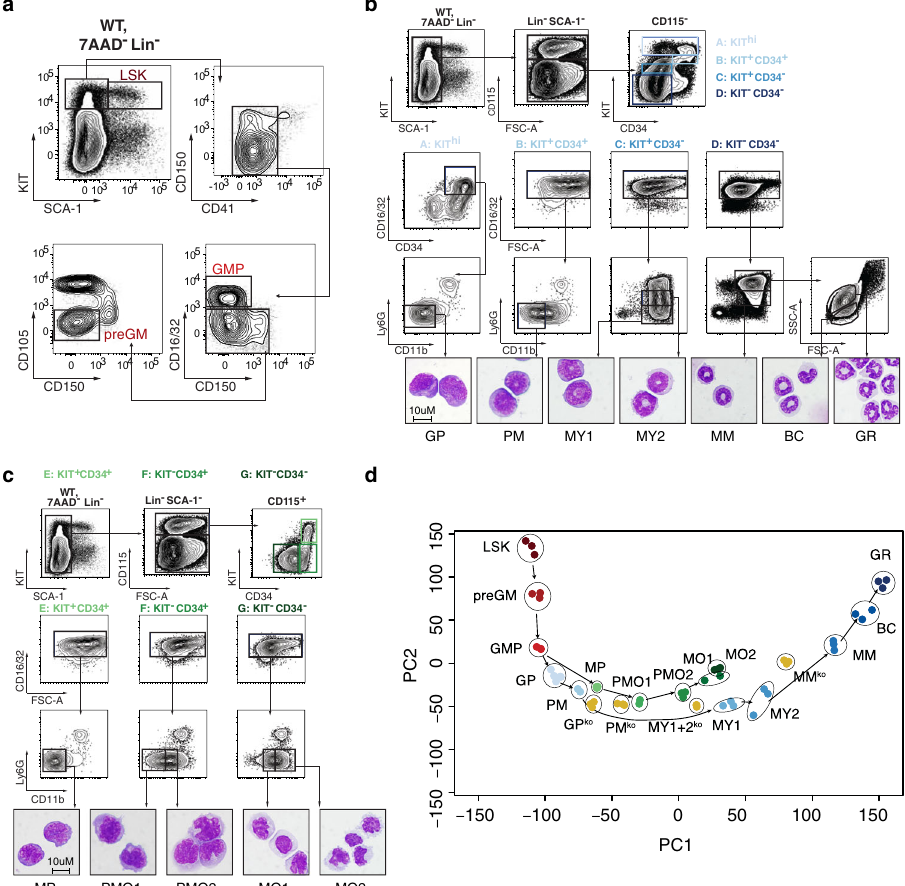
Fig. 1 High-resolution immunophenotypic and transcriptome mapping of steady-state granulocytic and monocytic differentiation hierarchies. a – c Flow cytometry-based gating strategy for sorting of murine bone marrow (BM) populations representing early stages of myeloid (i.e., granulocytic-monocytic) differentiation ( a ) and late stages of granulocytic ( b ) and monocytic differentiation ( c ). d PCA plot of murine BM populations clustered based on the similarity of gene expression pro fi les. Replicates of BM populations are encircled. a Early myeloid (i.e., granulocytic-monocytic) differentiation hierarchy: LIN-SCA + KIT + hematopoietic stem and early progenitor (LSK), pre-granulocyte-monocyte progenitors (preGM), and granulocyte-monocyte progenitors (GMP). b Late granulocytic differentiation hierarchy: Granulocyte progenitors (GP), promyelocytes (PM), early and late myelocytes (MY1, MY2), metamyelocytes (MM), band cells (BC), and fully mature granulocytes (GR). c Late monocytic differentiation hierarchy: Monocyte progenitors (MP), early and late promonocytes (PMO1, PMO2), and early and late monocytes (MO1 and MO2). Source data are provided as a Source Data fi